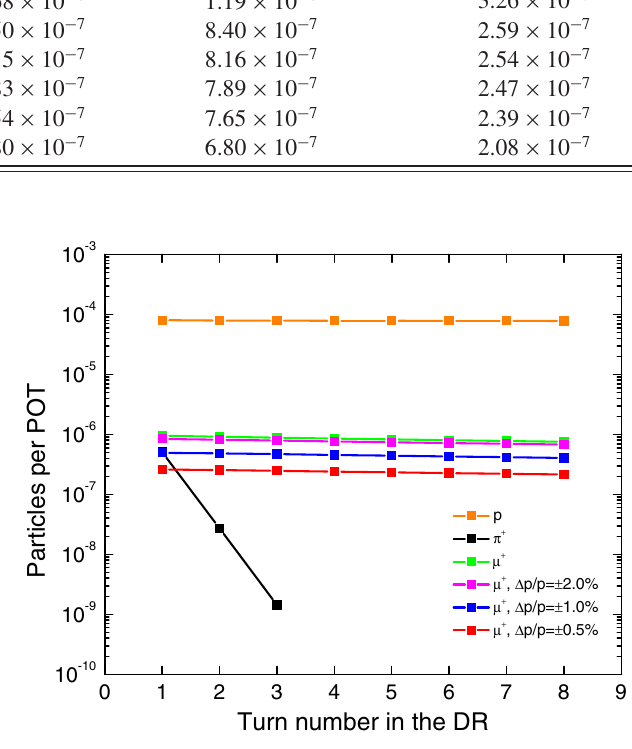
FIG. 6. The simulated performance along the DR, where the evolution of secondary particles is given as a function of the number of turns for different momentum acceptances. One should note that all pions decay to muons after the third turn.